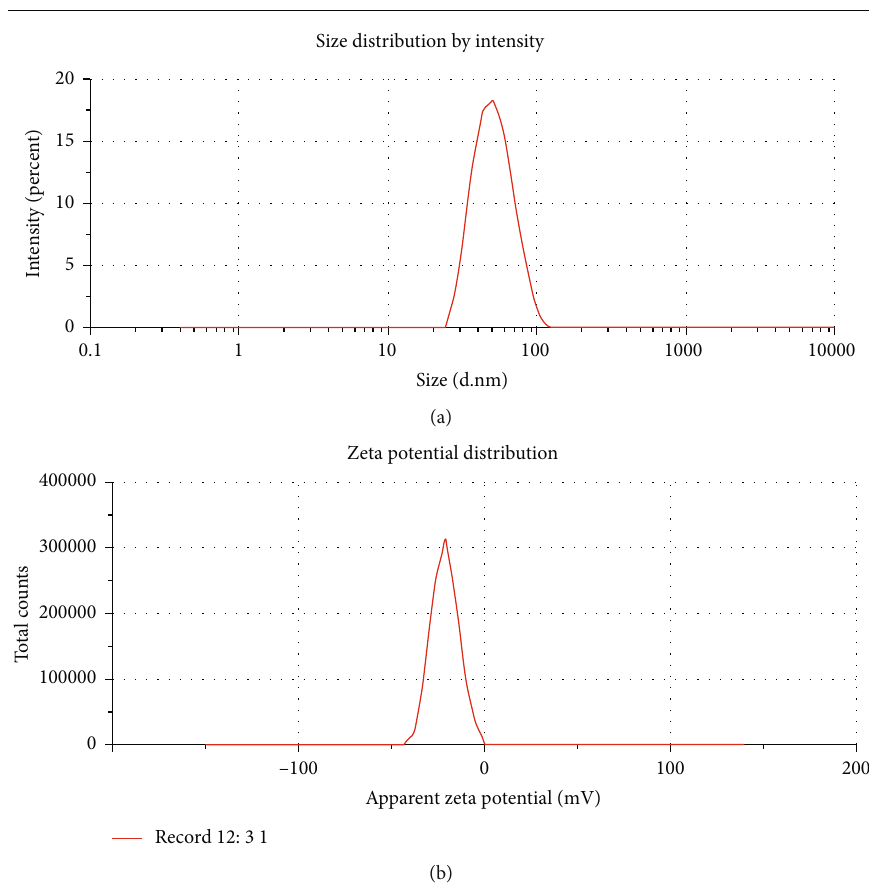
Figure 2: (a) DLS analysis of synthesis of Se NPs. (b) Zeta potential of synthesis of Se NPs.